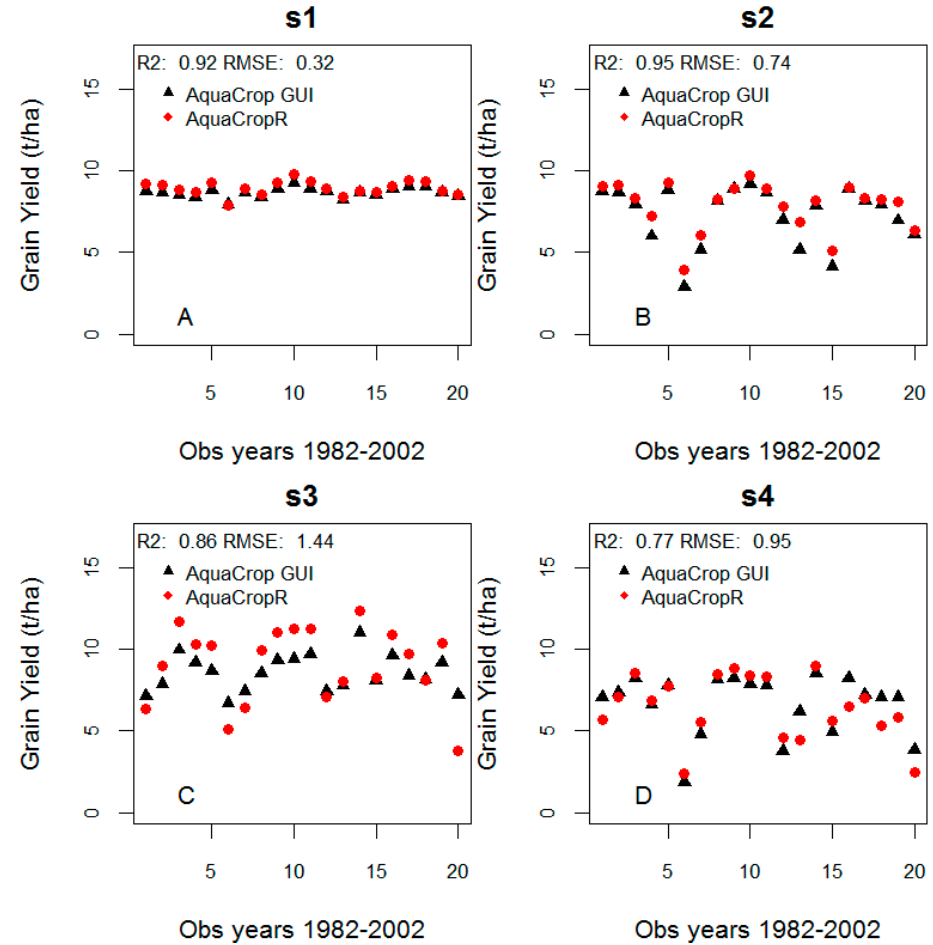
Figure 2. Simulated wheat yields from 1982 to 2002, according to four experimental scenarios (s1–s4): ( A ) default soil; ( B ) local soil; ( C ) late-maturing wheat variety; ( D ) irrigation schedule. R 2 and RMSE, which measure the fit between AquaCrop GUI and AquaCropR, are shown for each test.